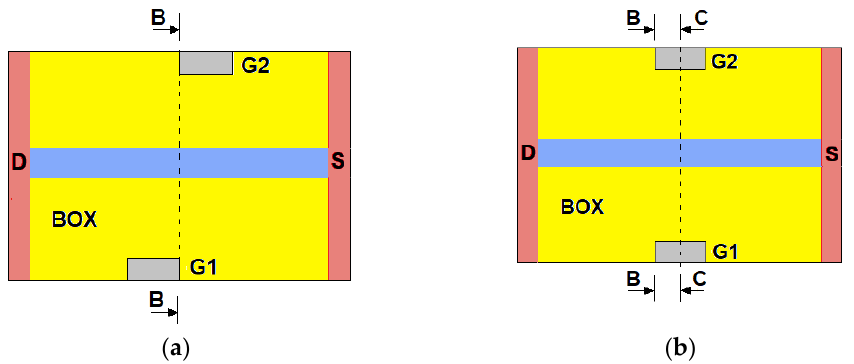
Figure 2. Schematic images of the sensor with (a ) asymmetric and ( b ) symmetric DEP electrodes.